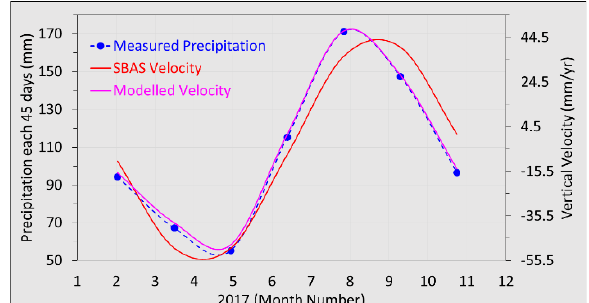
Figure 9. Comparison between precipitation and velocity for target point 6 (Figure 3). Measured precipitations are accumulated every 45 days from daily measurements (Figure 8).